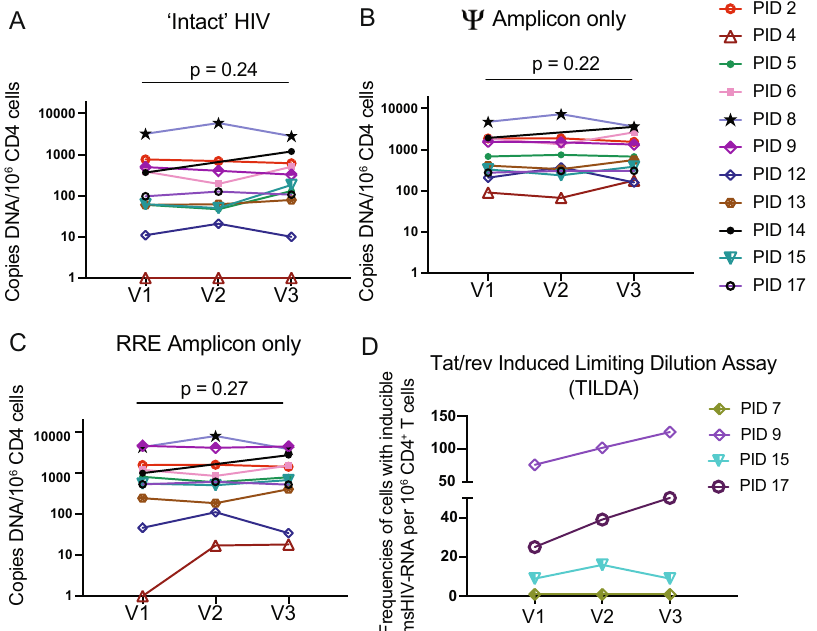
Fig. 6 | No consistent changes in HIV reservoir measures following COVID vaccinations.A – C CopiesoftheindicatedHIVDNAspeciesforARV-treateddonors at baseline (V1), and ~2 weeks after vaccine dose 1 (V2) or vaccine dose 2 (V3). P values were calculated by one-tailed Wilcoxon matched pairs signed rank test